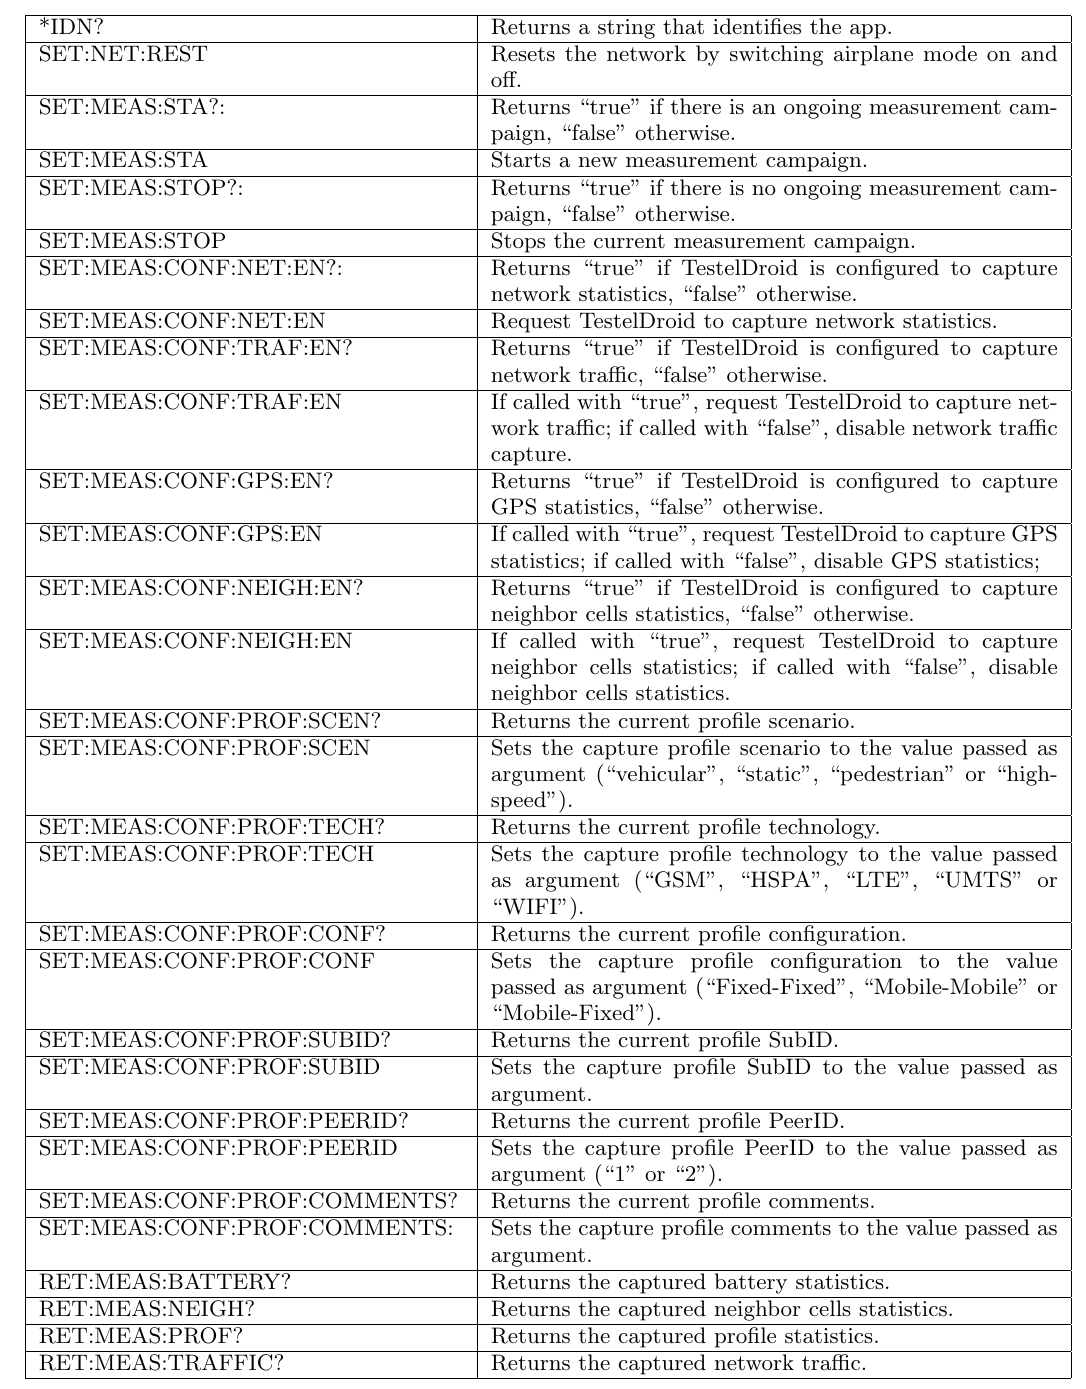
Table 1: SCPI interface provides by